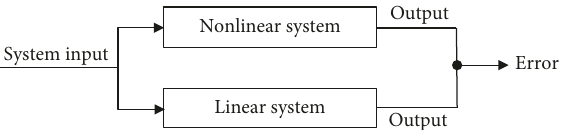
Figure 4: Setup for the comparison of a nonlinear system with a linear